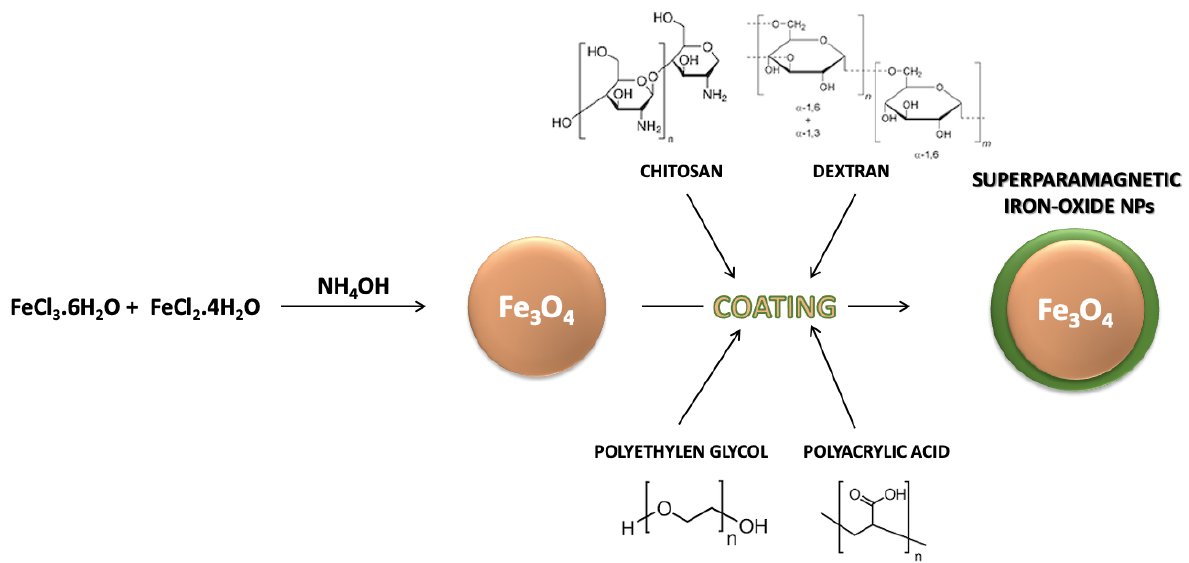
Figure 2. Iron NPs (Fe 3 O 4 NPs) can be prepared by the chemical coprecipitation method and enriched with an external coating, including polyethylen glycol, polyacrylic acid, chitosan or